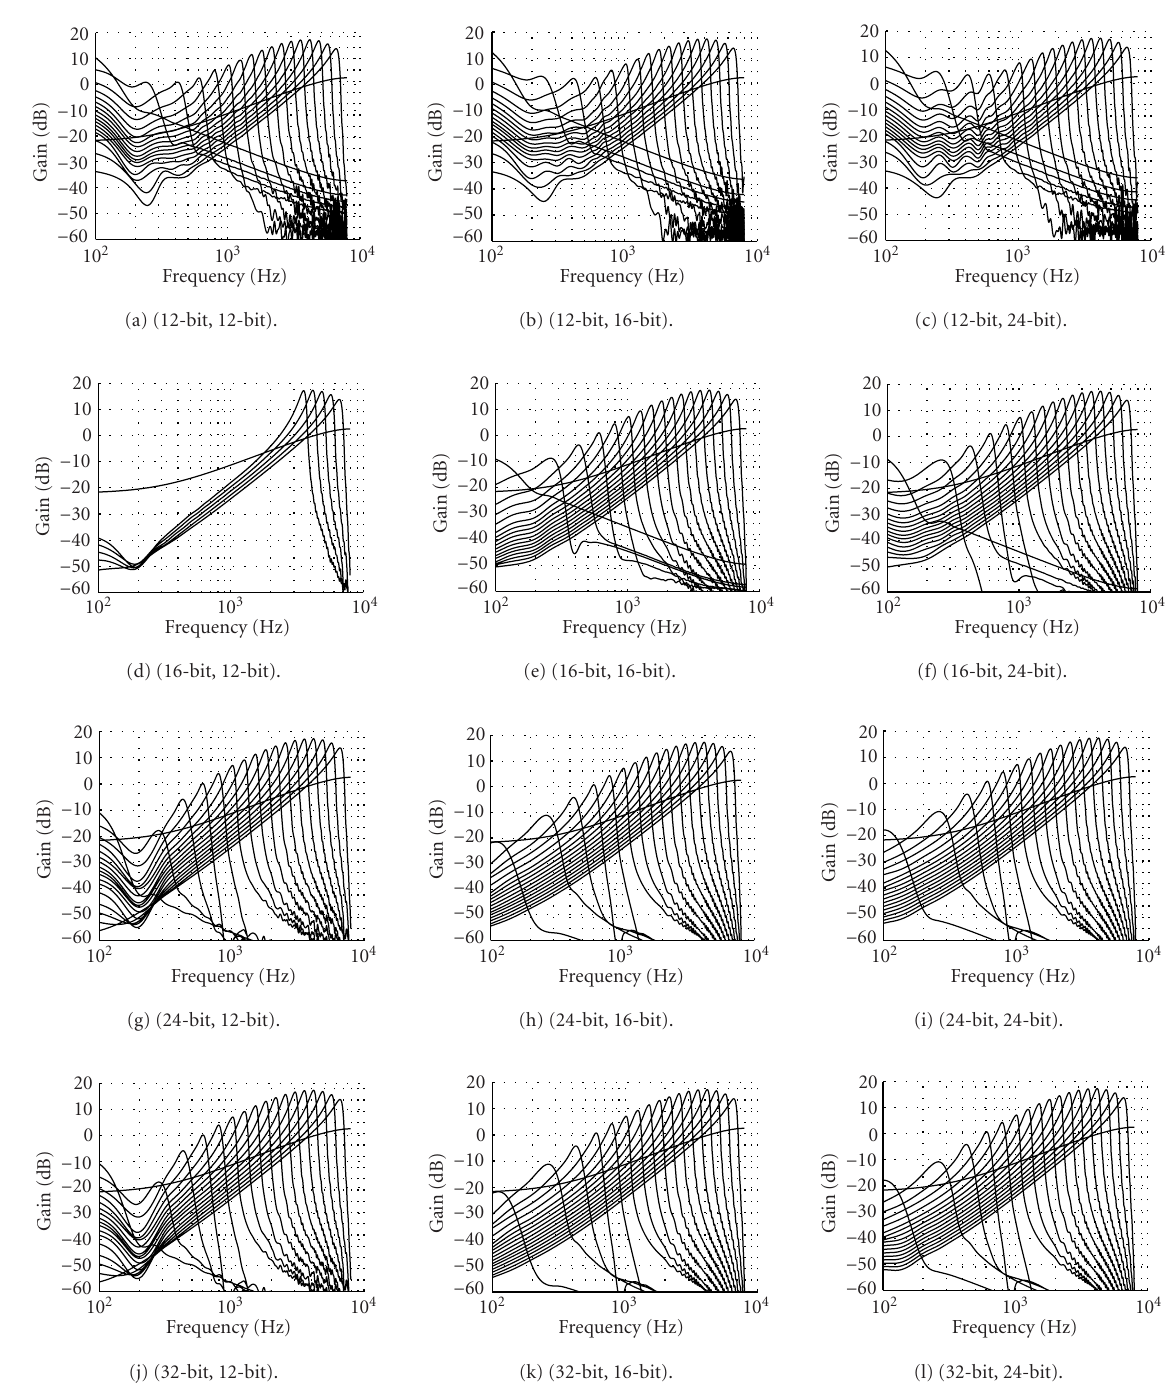
Figure 5: Frequency responses of cochlea implementations with di ff erent wordlength and width of ROMs (wordlength, ROM width).